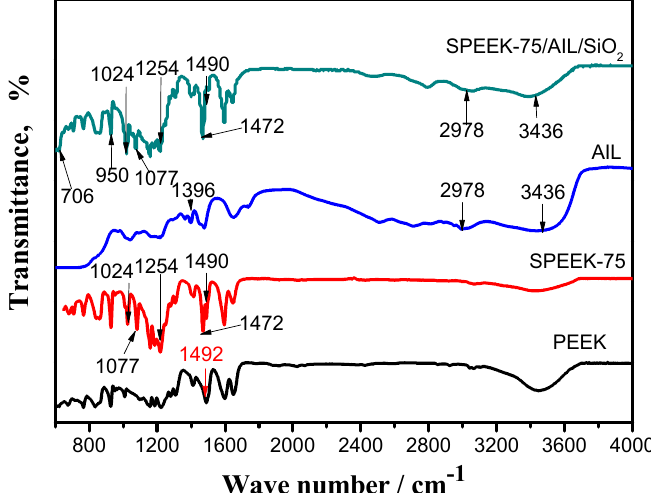
Figure 2. The Fourier transform infrared (FTIR) spectra of the poly(ether ether ketone) (PEEK), sulfonated poly(ether ether ketone) (SPEEK)–75, AIL, and SPEEK–75/AIL/SiO 2 composite membranes.